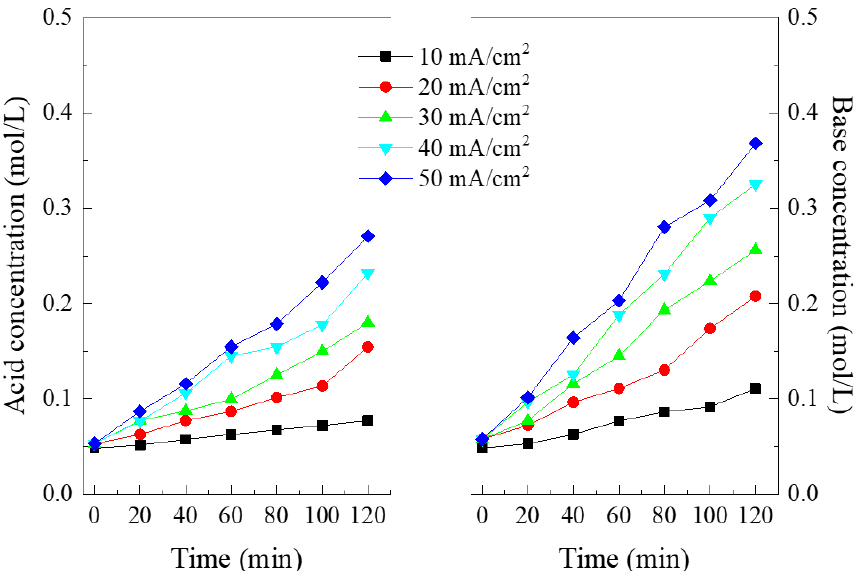
Figure4. E ff ectofthecurrentdensityontheevolutionoftheacidconcentrationintheacidIcompartment Figure 4. Effect of the current density on the evolution of the acid concentration in the acid I and base concentration as a function of compartment and base concentration as a function of time.